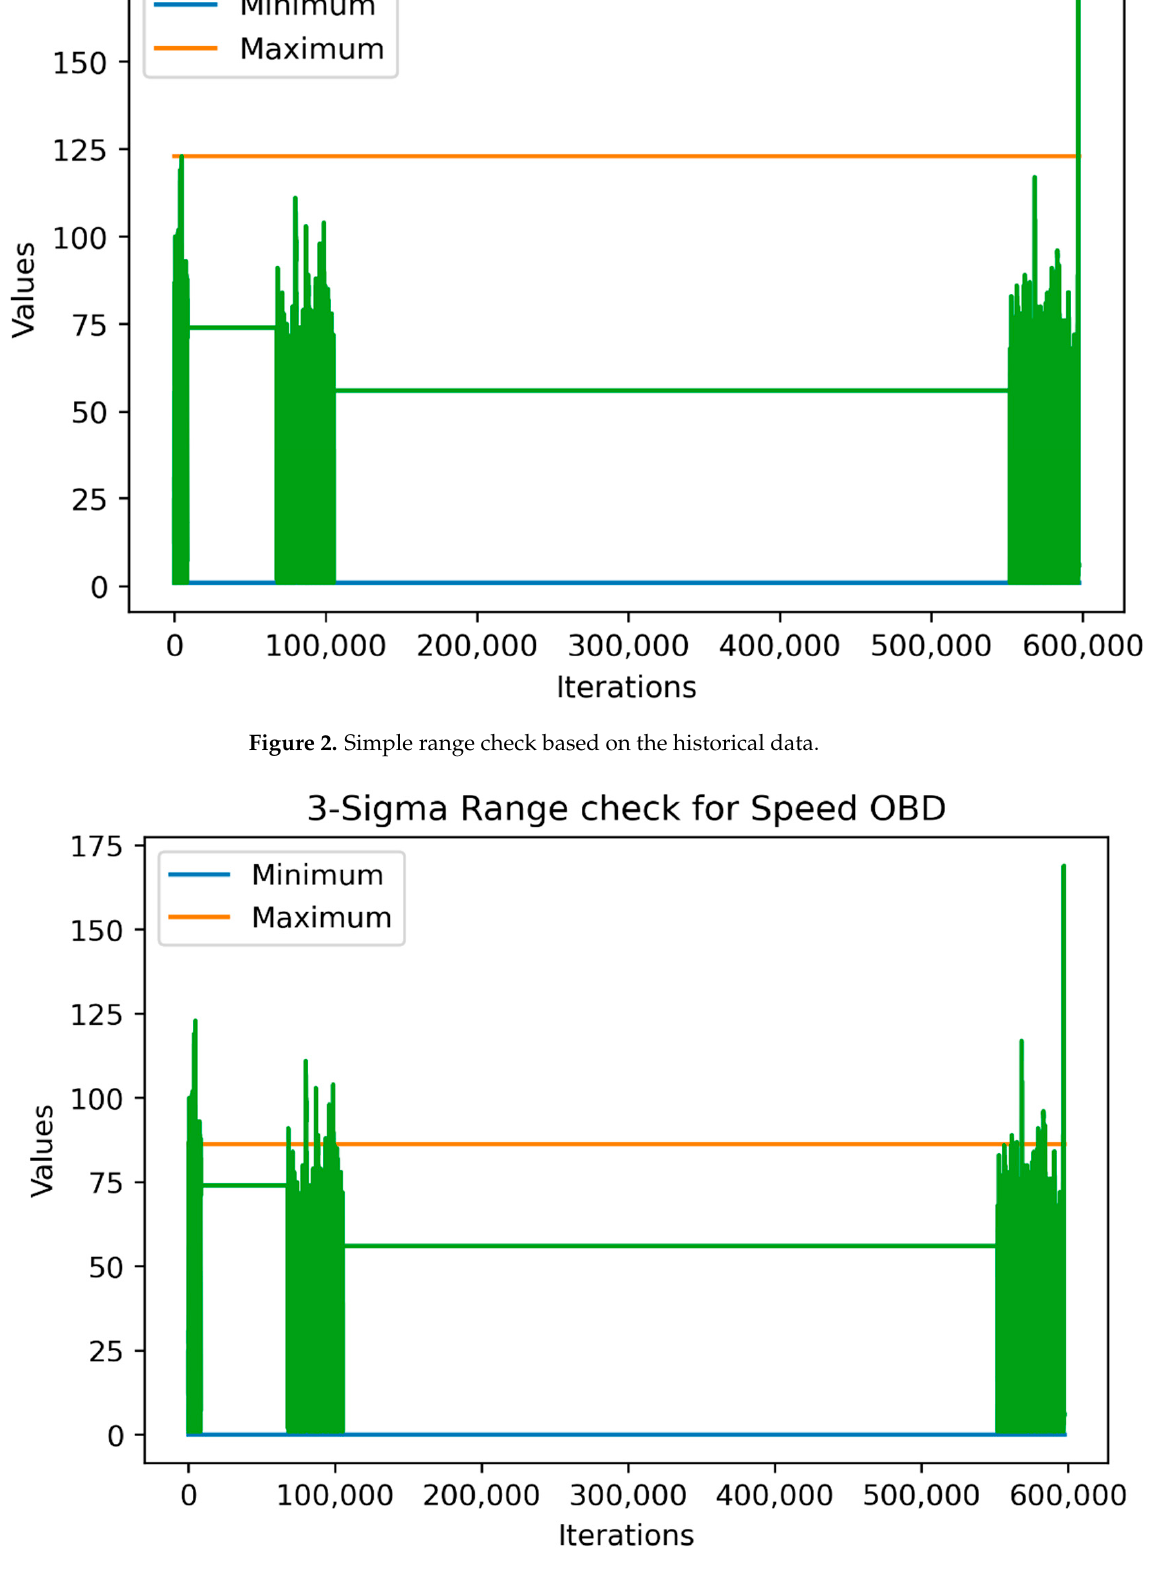
Figure 3. Range check using the “three-sigma” approach based on the historical data.